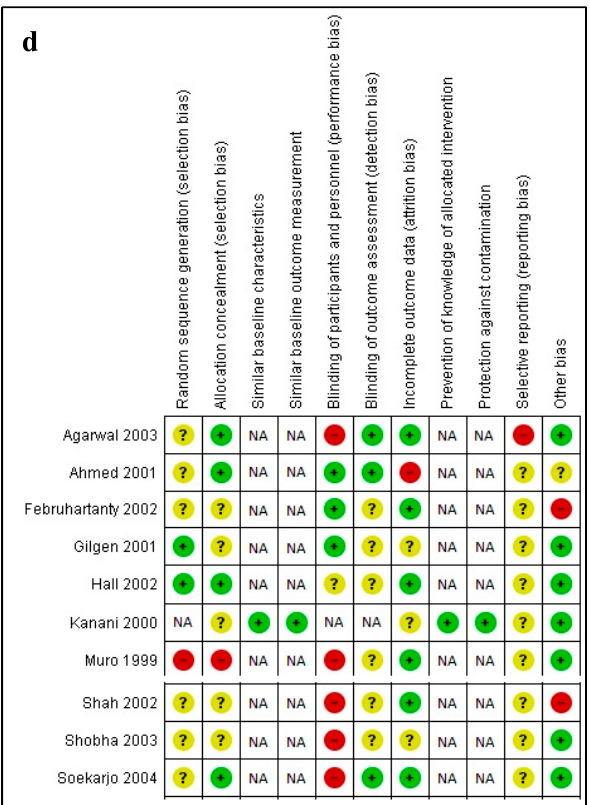
Figure 3. Risk of bias assessment comprised of Cochrane and EPOC criteria. Green: low risk; Red: high risk; Yellow: unclear; NA: not applicable to risk of bias due to study type. (a). delaying early pregnancy intervention, (b). prolonging inter-pregnancy intervals; (c): peri-conceptional iron-folic acid supplementation; (d). peri-conceptional folic acid supplementation.